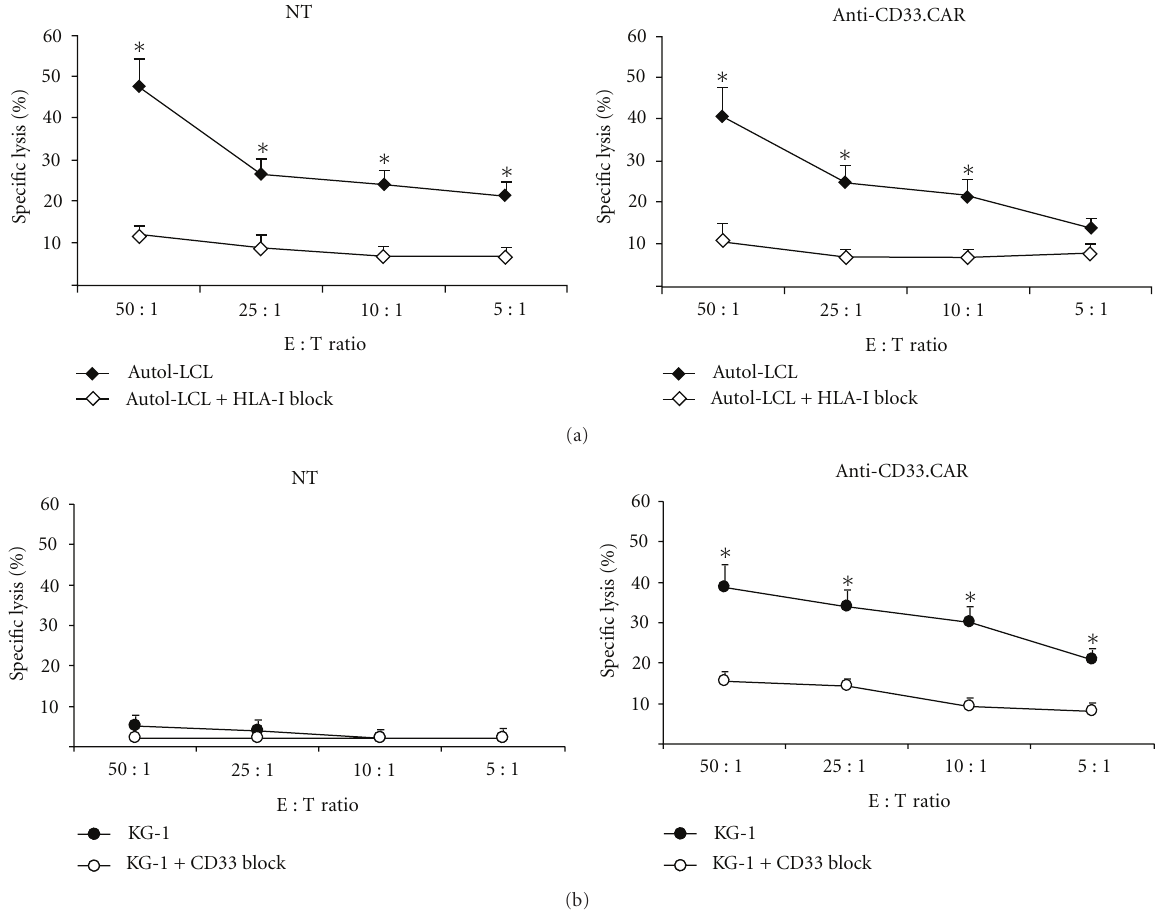
Figure 2: Anti-CD33.CAR-transduced EBV-CTLs e ffi ciently killed autologous LCLs and CD33+ KG-1 cells. Cytotoxicity of unmanipulated EBV-CTLs and anti-CD33.CAR-transduced EBV-CTLs was evaluated by a standard 4-hour 51 Chromium-release assay after 7 days of culture at e ff ector:target (E:T) ratios of 50 :1, 25: 1, 10:1 and 5 :1 against autologous LCLs (a) and CD33 + KG-1 cell line (b). To assess the specificity of either HLA-I-mediated and CAR-induced killing, target cells were preincubated with anti-human HLA-I (a) antibodies or an anti-human CD33 monoclonal antibody (b) before the addition of the e ff ector cells. Data shown are mean ± SD of 6 separate experiments; ∗ P ≤ 0 .